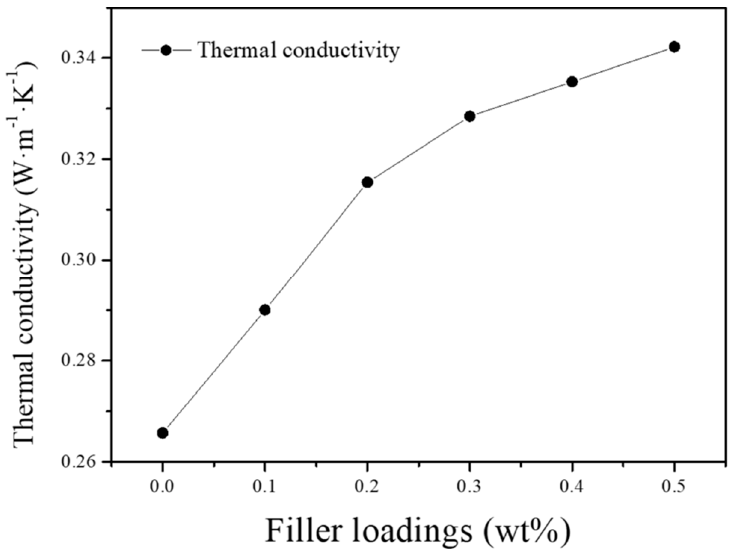
Figure 14. Thermal conductivity of PA66 and EG/PA66 composites.